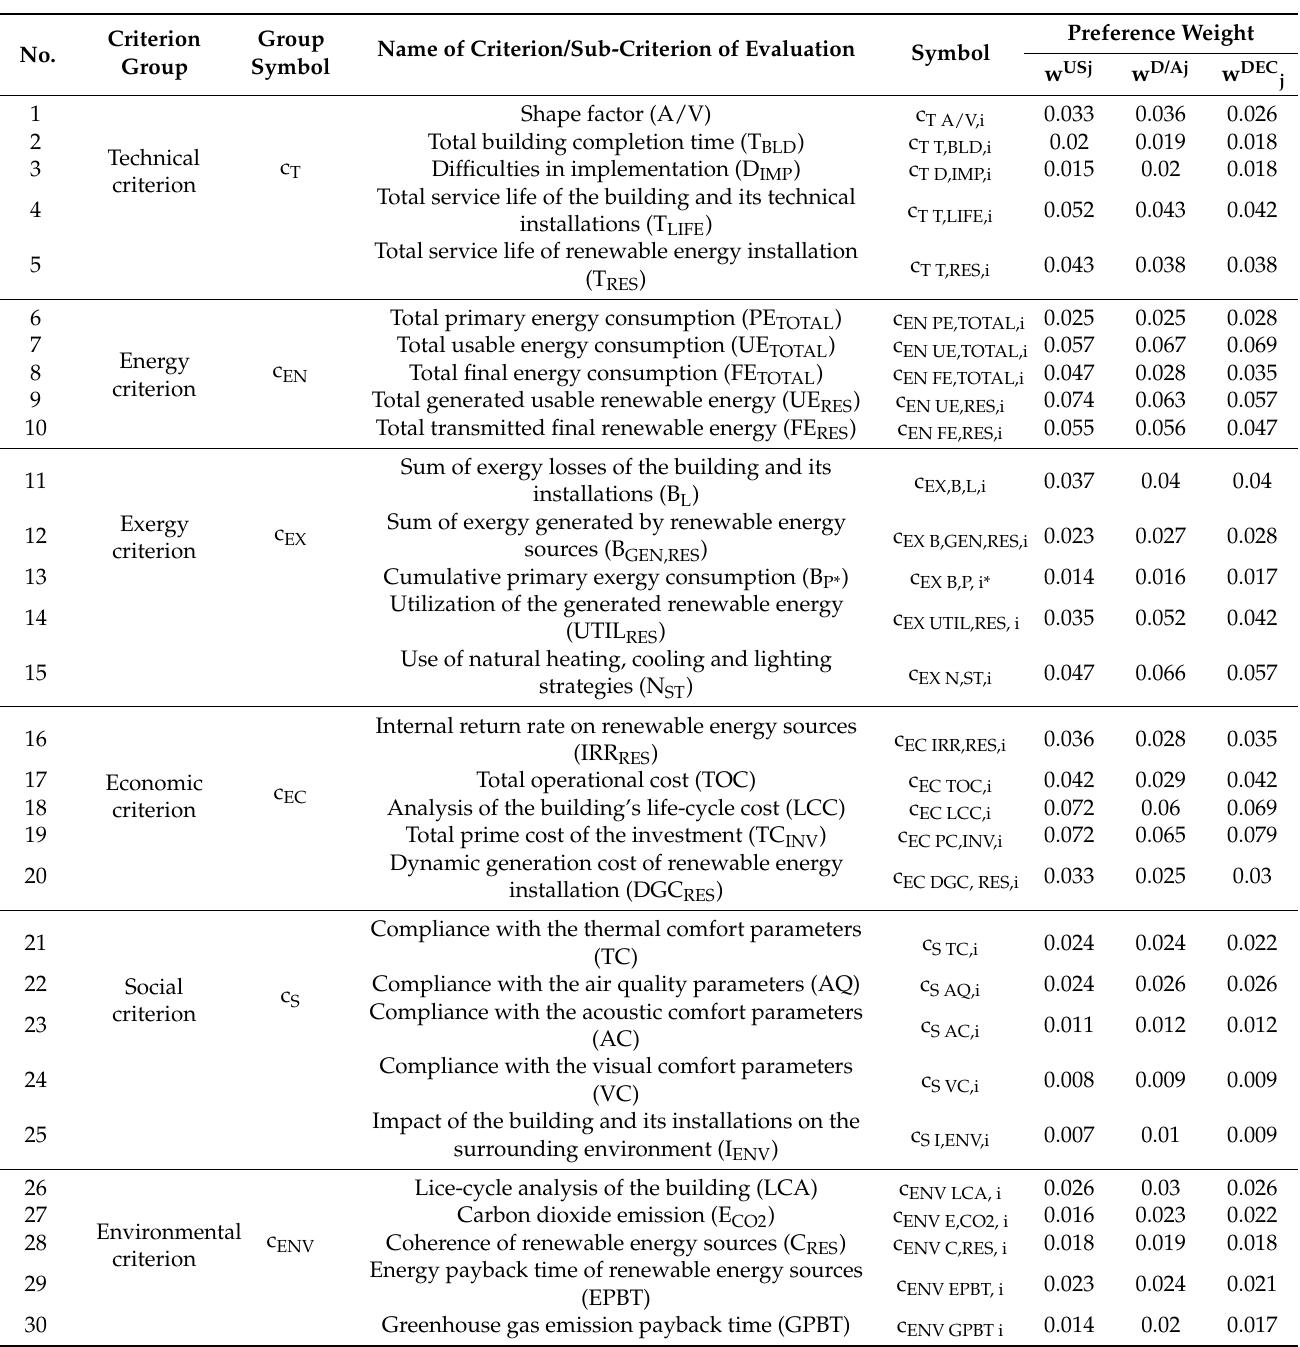
Table 5. Normalized weights of preferences for all evaluation sub-criteria-“Current/Future user”, “Designer/Architect” and “All